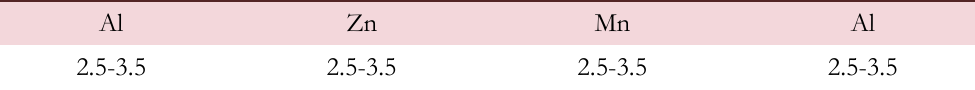
Table 1: Table of AZ31B alloy chemistry in wt.